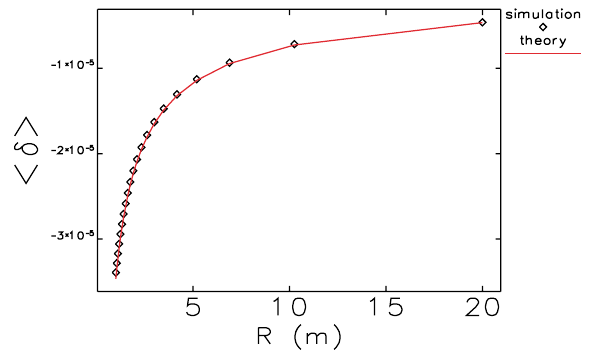
FIG. 2. (Color) Mean fractional momentum offset vs bending magnet radius.